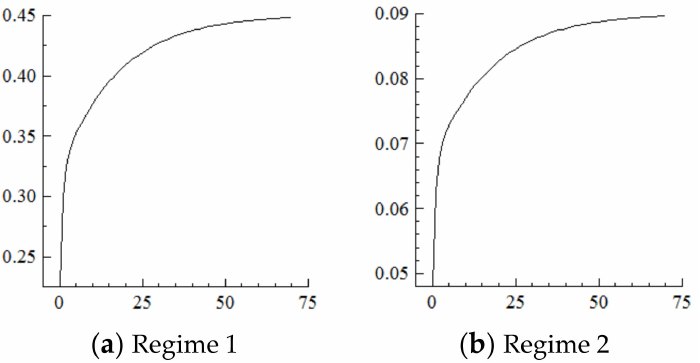
Figure 4. Cumulative Impulse Response of Industrial structure upgrading to Labor Supply